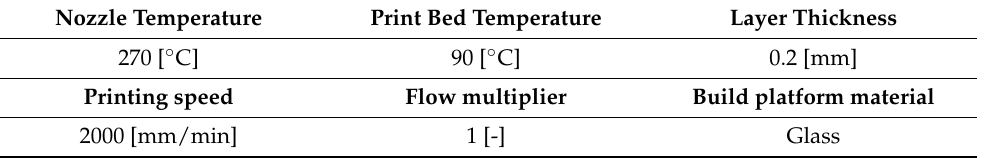
Table 2. Settings for the printing of the tensile test specimens with the LulzBot TAZ5. Nozzle